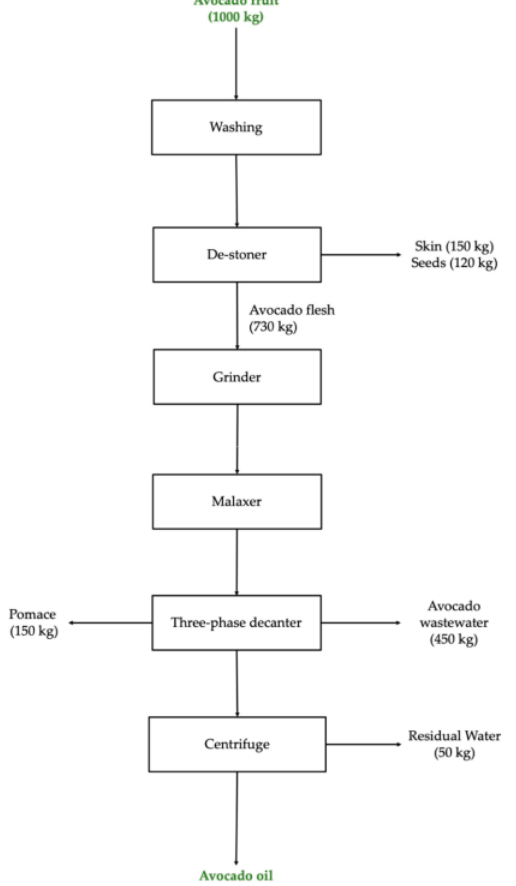
Figure 1. Process flow diagram of a typical commercial cold pressed avocado oil (CPAO) extraction process. All the avocado waste output values from the early harvest season were obtained using an input of 1000 kg avocado fruits as the